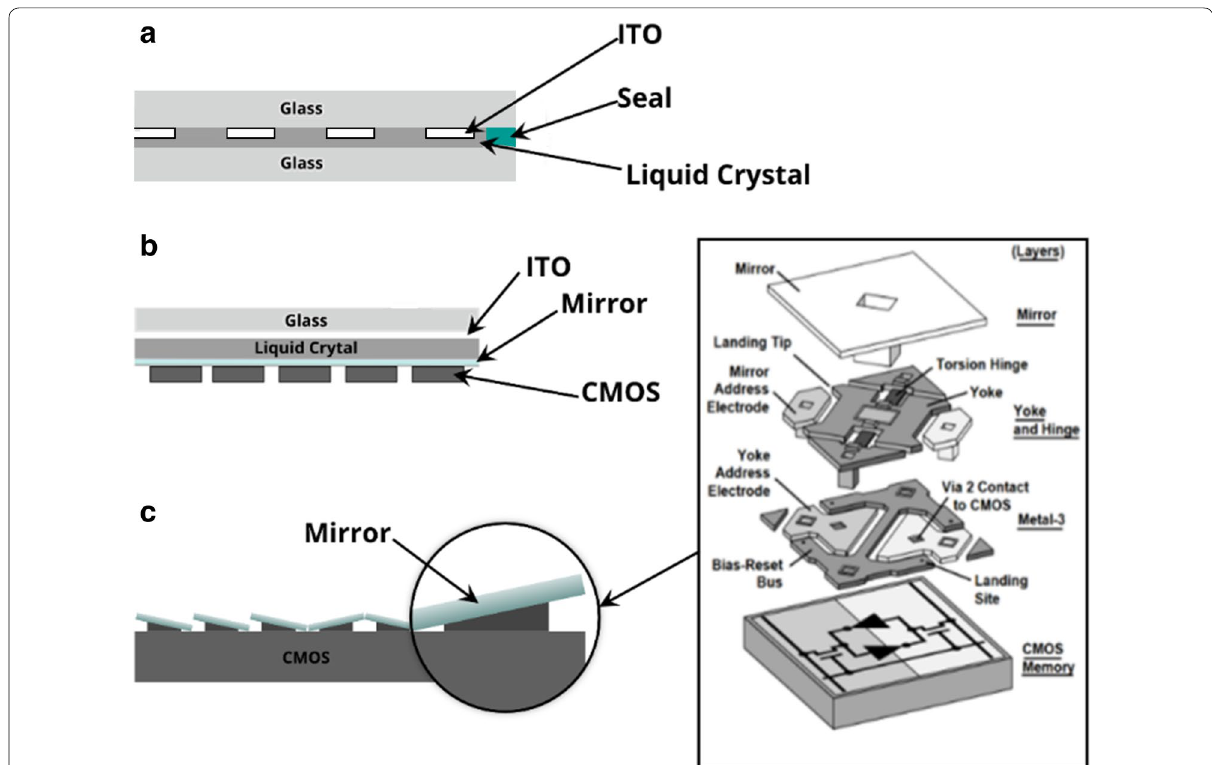
Fig. 5 Advanced beam shaping devices. a Transmissive LCD panel. b Reflective Liquid Crystal on Silicon (LCOS) panel. c Digital micromirror device and a detailed schematic of its internal structure. The inset is the DMD pixel exploded view (Adapted from Hornbeck